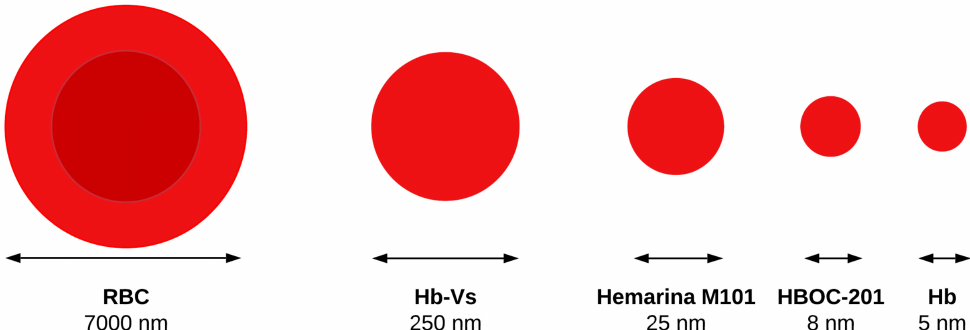
Figure 3. Visualizing the large differences in size between various oxygen carriers: red blood cells (RBC), hemoglobin vesicles (Hb-Vs), hemoglobin-based oxygen carrier 201 (HBOC-201), human hemoglobin